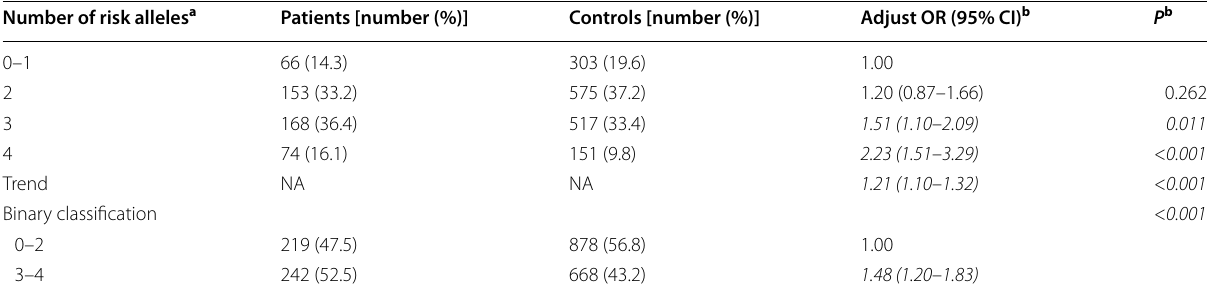
Italic value indicate significance of p value ( p < 0.05) a